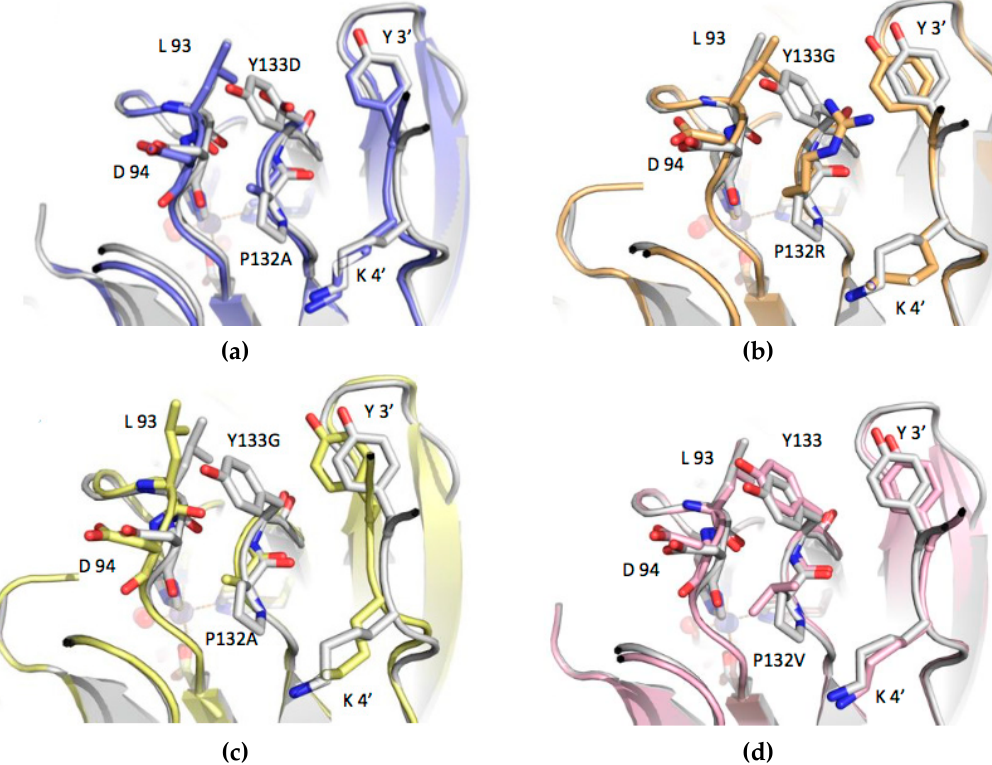
Figure 4. Comparison of the structure of the loops adjacent to the mutation position in the four mutant structures. In each panel, the structure of the wild-type enzyme (PDB code: 1X7N) is shown in white, with the relevant residues highlighted in stick representation and labelled. Y3 ′ and K4 ′ refer to the N-terminal strand from the adjacent subunit in the dimer. ( a ) Mutant AD (slate), (PDB code: 4LUL); ( b ) mutant RG (wheat), (PDB code: 4LTA); ( c ) mutant AG (yellow), (PDB code: 4LUK); and ( d ) mutant VY (pink), (PDB code: 4LUM).